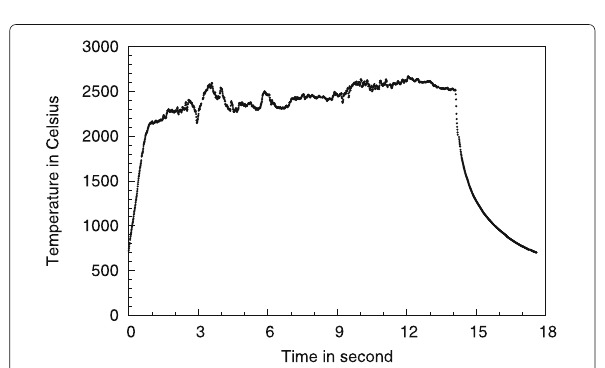
Fig. 4 Time-temperature profile of the MLB surface in run# 3 (200 W). The temperature is recorded automatically once it exceeds 700 °C. The laser power was shut off after 14 s, at which point radiative cooling